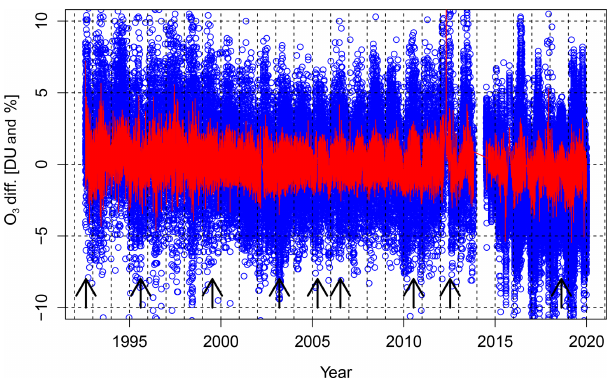
Figure 3. Time series of the differences between individual coinci- dent measurements of the Dobson instruments D 062 and D 101 over the period 1992–2019. Blue: difference D 062 − D 101 in Dobson units [DU]. Red: difference D 062 − D 101 / D 101 in percent. Black arrows indicate the calibration and maintenance